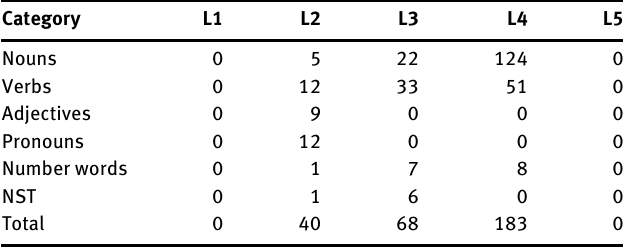
Table 5: Morphological DI